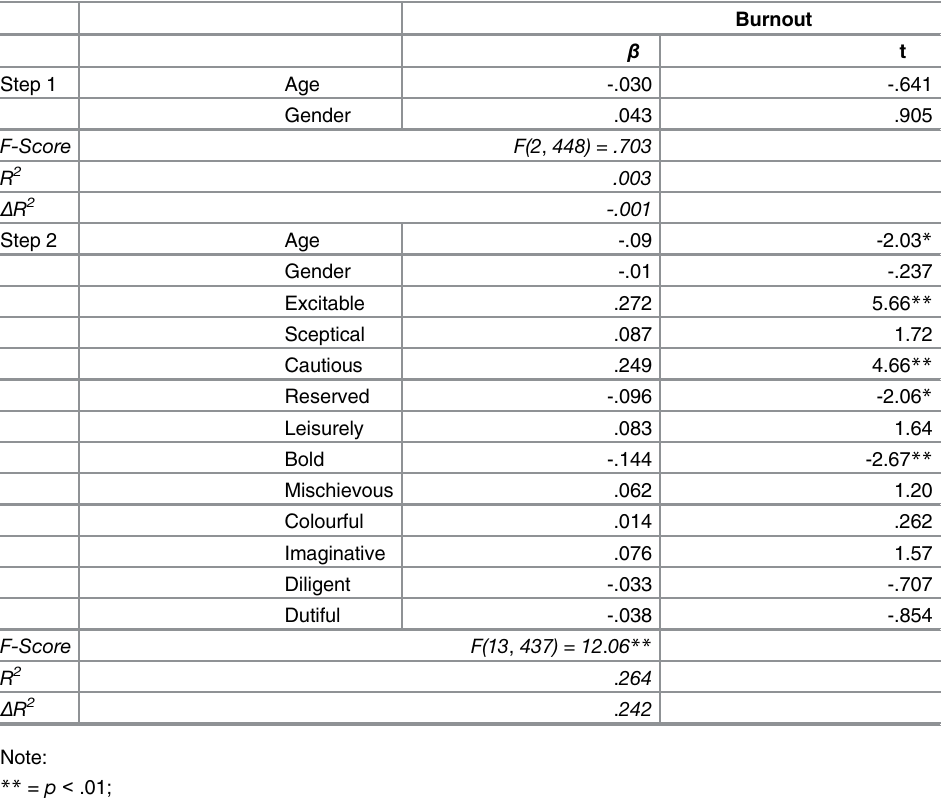
Table 6. Regression of Age, Gender, and HDS Dark Side as predictors of CBI work-related